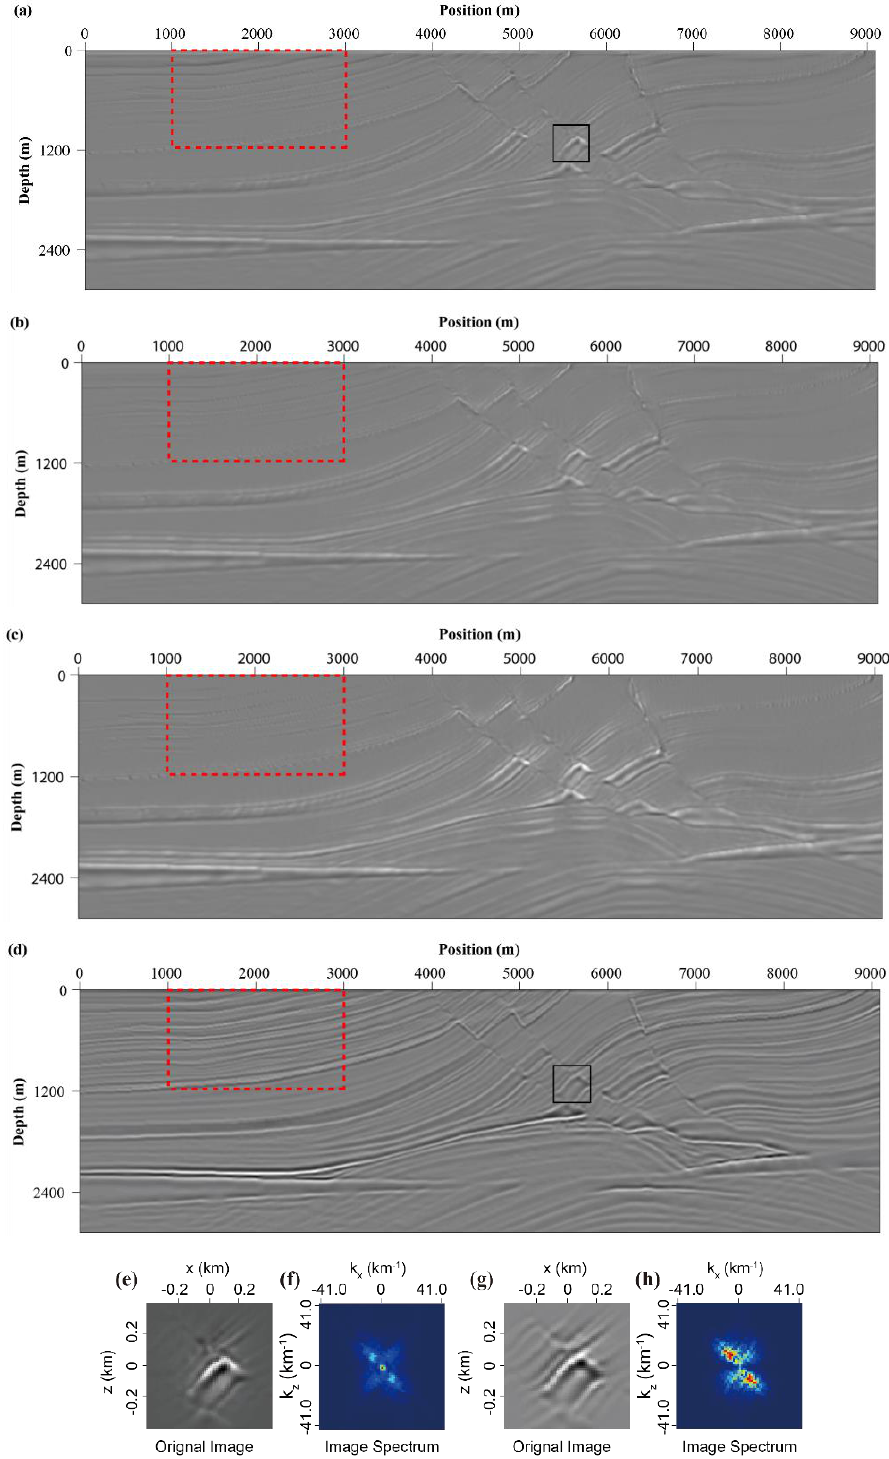
Figure 8. Comparison of the stack images of reflection angle from 0 to 50° by using ( a ) Method 1, ( b ) Method 2, ( c ) Method 3 and ( d ) Method 4. In the bottom panel, ( e , g ) are the local images marked by black squares in ( a , d ) respectively, and ( f , h ) are corresponding wavenumber spectra respectively. The true velocity model is used for migration. All four images are regularized to the same amplitude scale.